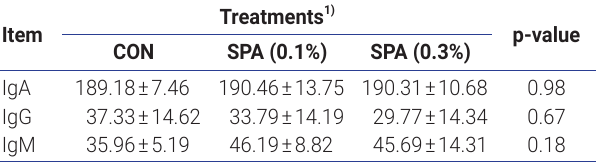
Table 6. Effect of supplementary SPA on immunoglobulins in laying hens